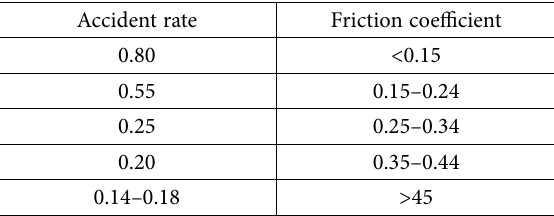
Table 1. Friction coefficients and car accident rate – personal injuries per million vehicle